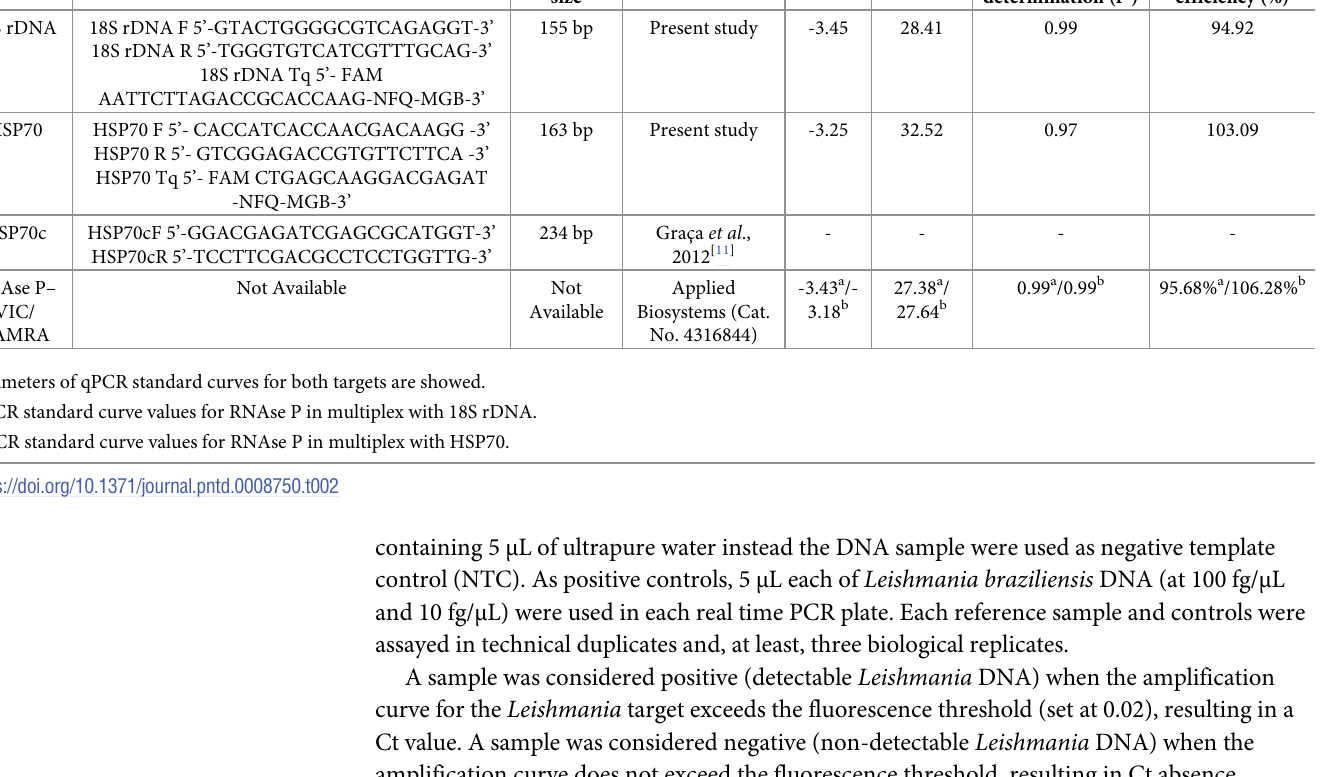
Table 2. Primers, probes and standard curve parameters for the targets used in the conventional and real time PCR assays.